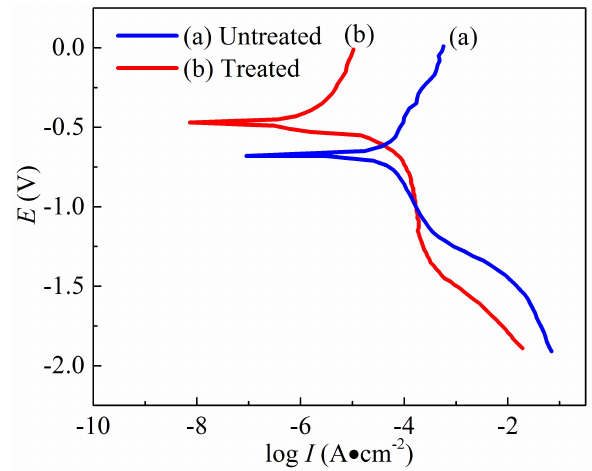
Figure 7. Potentiodynamic polarization curves of the ( a ) untreated and ( b ) treated Ti6Al4V surfaces.